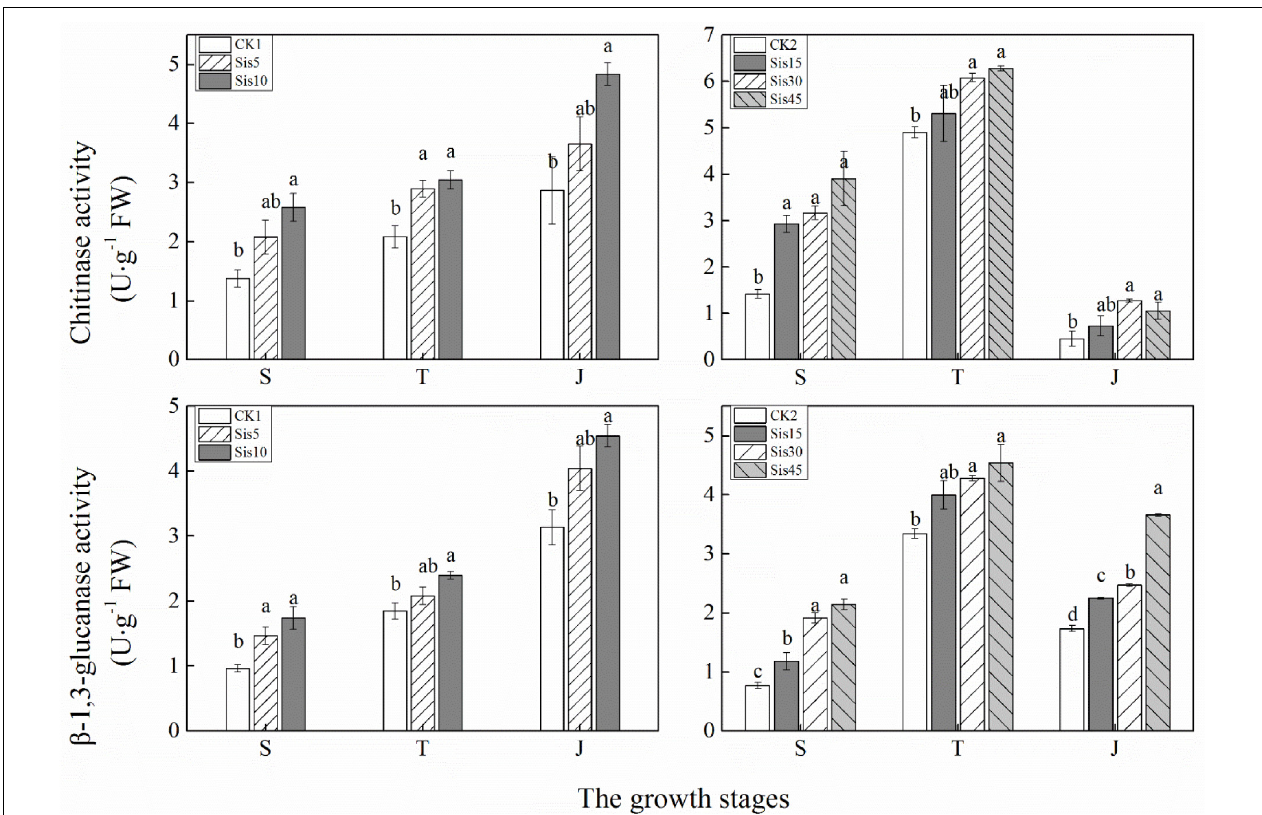
FIGURE 3 | Effects of silicon application on chitinase and β -1,3-glucanase activities in sugarcane leaves under Sporisorium scitamineum stress. Various lowercase letters represent significant differences at the P level of 0.05. S, seedling stage; T, tillering stage; J, jointing